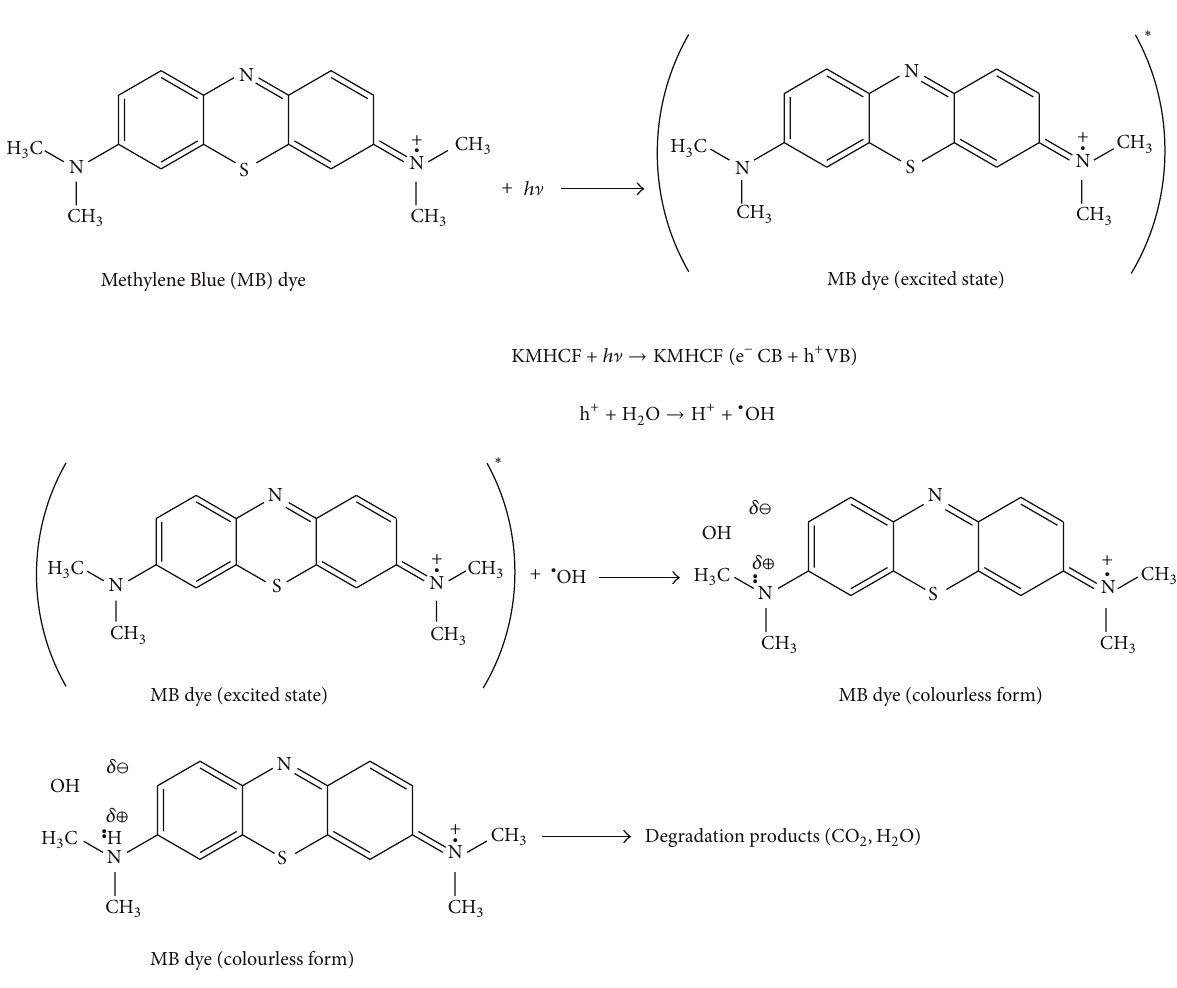
Figure 8: Photocatalytic degradation of MB in presence of KMHCF nanoparticles.